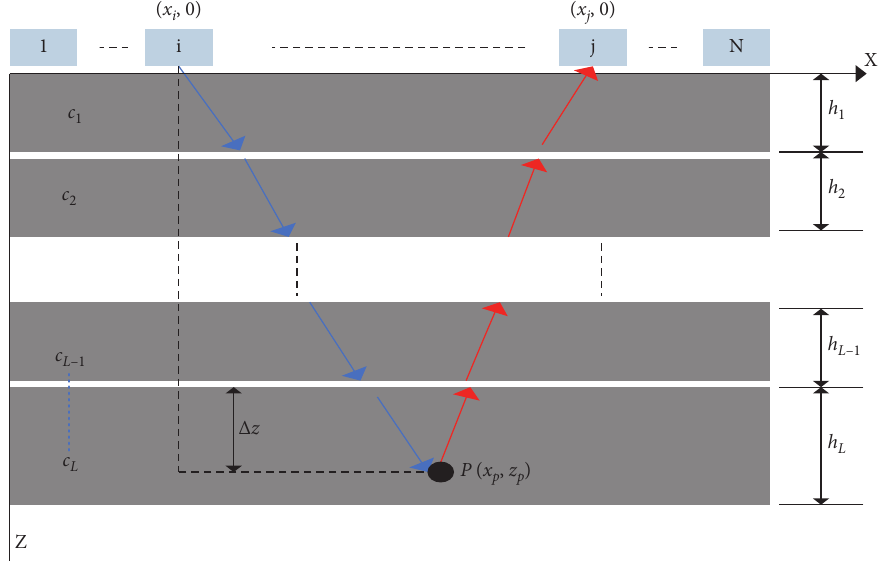
Figure 3: Wave propagation through multilayer with different sound